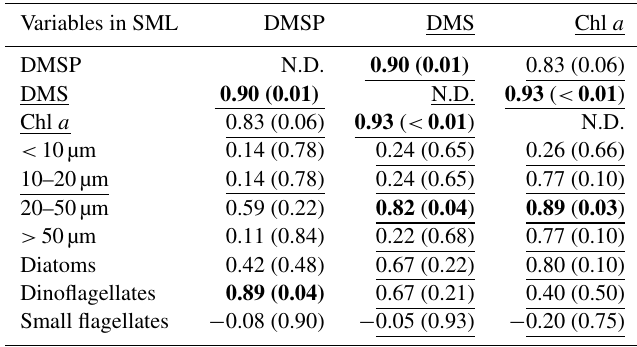
Table 2. Summary of Pearson test and Spearman’s rank correlation (underlined) for DMSP, DMS, and all ancillary variables in the SML. The correlations are significant where r or rho (for Pearson and Spearman’s rank tests, respectively) is > 0.5 and p < 0.05, as indicated in bold. The size fraction biovolumes were obtained from Flowcam, and the phytoplankton community composition was obtained from optical